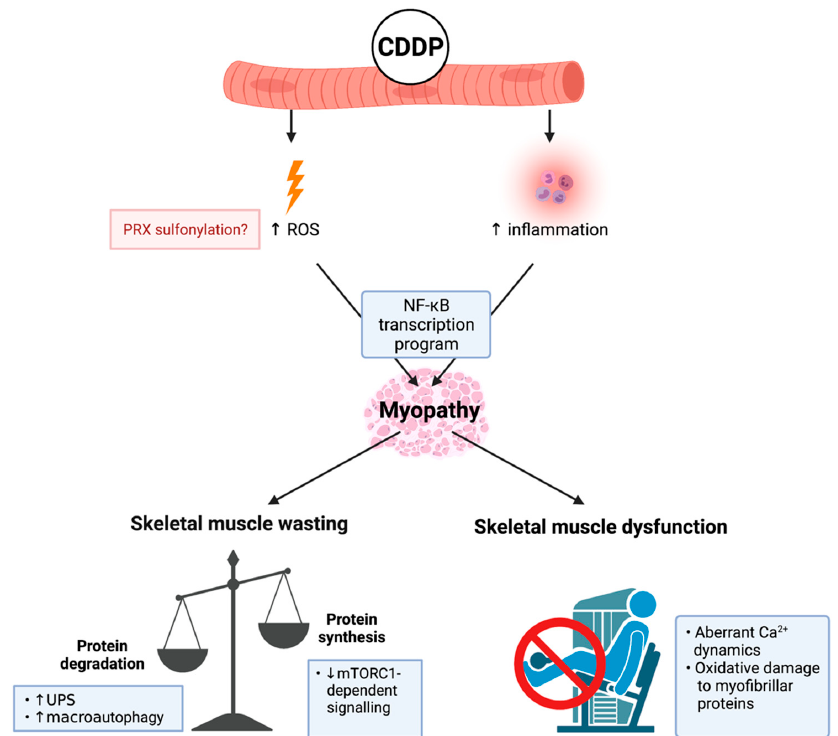
Figure 2. Known mechanisms of cisplatin (cis-diamminedichloropaltinum(II) (CDDP))-induced cachectic myopathy. CDDP promotes reactive oxygen species (ROS) production potentially through: (1) increased peroxiredoxin (PRX) sulphonylation; and (2) inflammation induced by pro- inflammatory cytokine mediated nuclear factor kappa-light-chain-enhancer of activated B cells (NF- κ B) transcription program activation, which is a central mechanism of CDDP-induced cachec- tic myopathy. The underlying mechanism regulating CDDP-induced skeletal muscle wasting is increased protein degradation involving elevated ubiquitin-proteasomal system (UPS) activity and